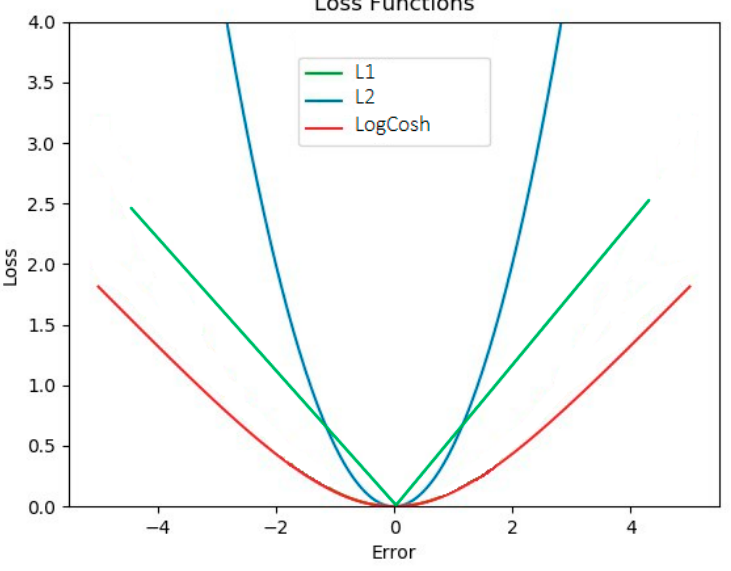
Figure 6. The comparison of L1, L2 and logCosh losses.